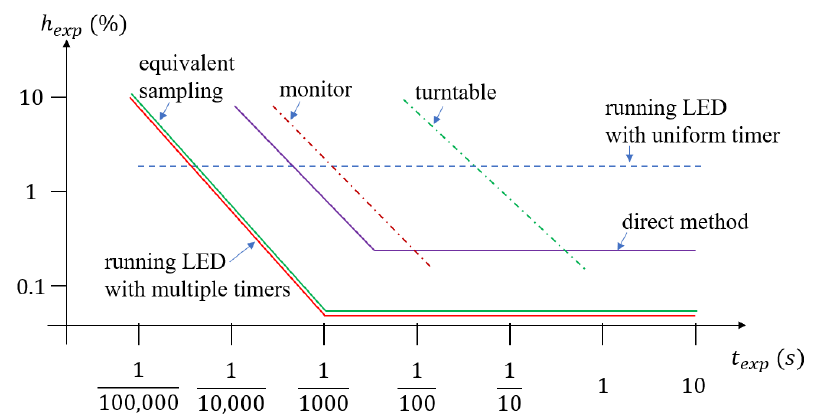
Figure 20. Accuracy and regions of applicability of the discussed